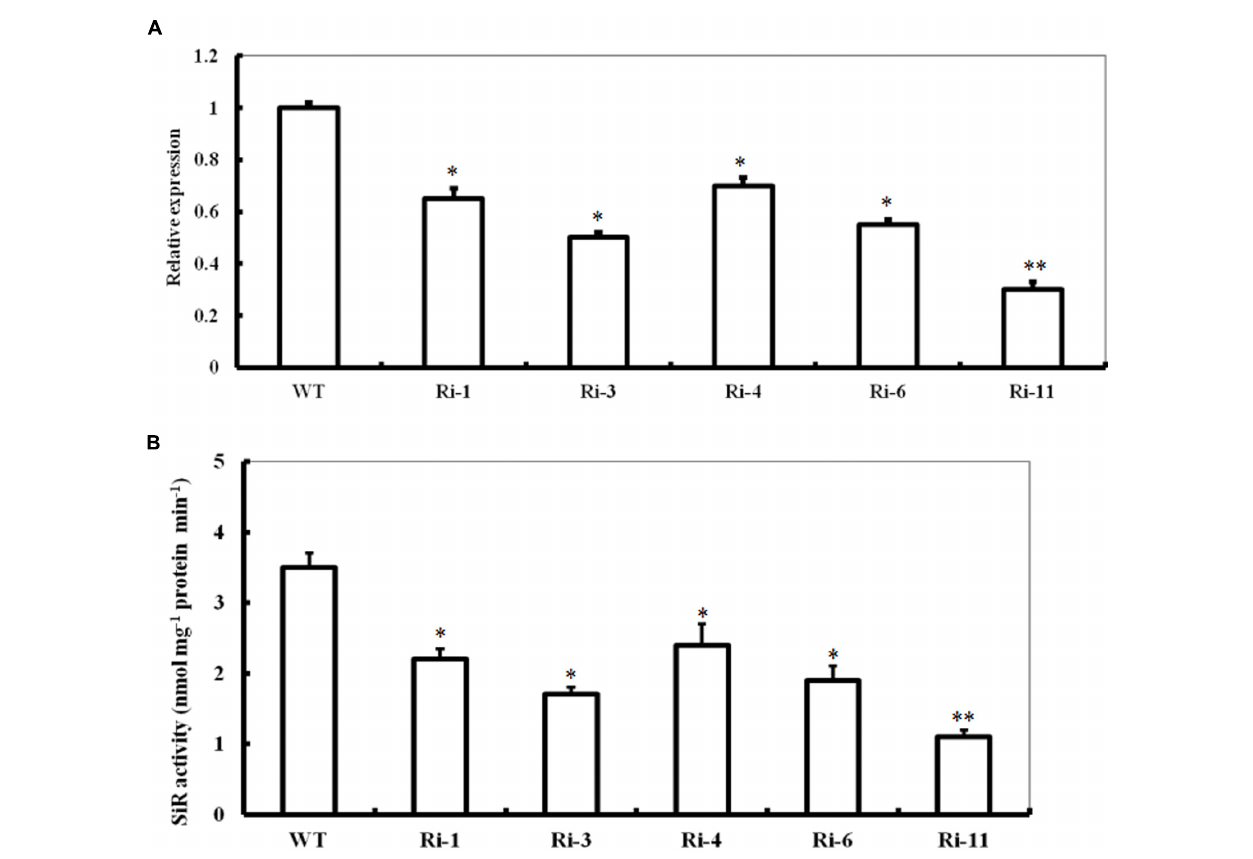
FIGURE 2 | Expression levels and activity of SiR in SiR -modified Arabidopsis plants. (A) Transcript levels of SiR in the WT and five RNA interference lines (named Ri-1, Ri-3, Ri-4, Ri-6, and Ri-11) determined by qRT-PCR. (B) Total SiR activity in leaf extracts from WT and RNAi lines. In both histograms above, values are mean ± SE. The asterisks indicate significance of the difference from the corresponding control values determined by Student’s t -test ( ∗∗ t -test, with P < 0.01; ∗ t -test, with P <